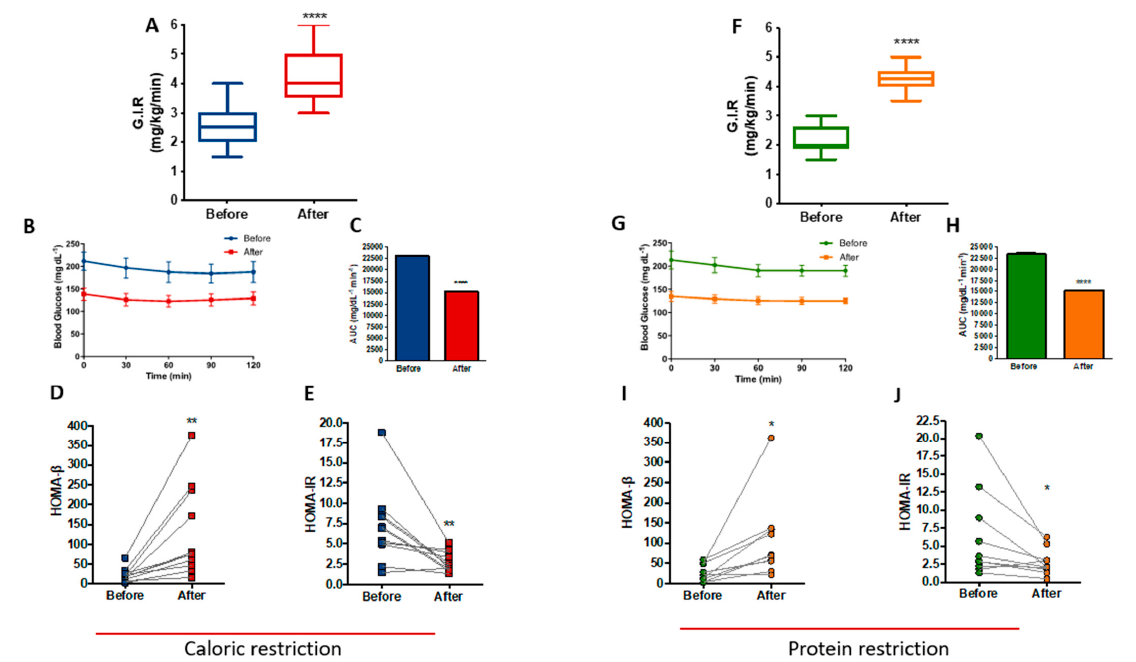
Figure 5. Improved insulin sensitivity after caloric restriction (CR) or protein restriction (PR). Results obtained using hyperinsulinemic-euglycemic clamp or HOMA- β and HOMA-IR. ( A ) Glucose infusion rate (GIR) comparing before and after caloric restriction (**** p = < 0.0001). ( B ) Glycemic curve during the clamp. ( C ) Area under the curve of B (**** p = < 0.0001). ( D ) HOMA- β comparing before and after caloric restriction (** p = 0.0056). ( E ) HOMA-IR comparing before and after caloric restriction (** p = 0.0057). ( F ) GIR comparing before and after protein restriction (**** p = < 0.0001). ( G ) Glycemic curve during the clamp. ( H ) Area under the curve of G (**** p = < 0.0001). ( I ) HOMA- β comparing before and after protein restriction (* p = 0.0199). ( J ) HOMA-IR comparing before and after protein restriction (* p = 0.0460). Data are shown in box plot and dot plot format. Paired t -test was performed.